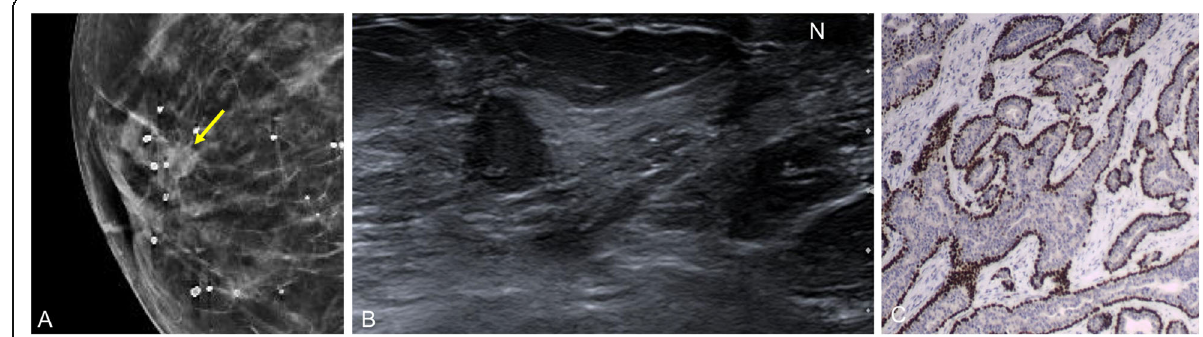
Fig. 26 Nipple adenoma. An 81-year-old woman with a several-week history of pain and swelling of the right breast. a Mammogram shows an isodense rounded retroareolar mass with slightly irregular margins (arrows); b on ultrasound, it is seen as a solid nodular lesion (N: nipple). c Immunohistochemistry stain with p63 (× 4) shows glandular and ductal proliferation consisting of epithelial and myoepithelial cells, which express